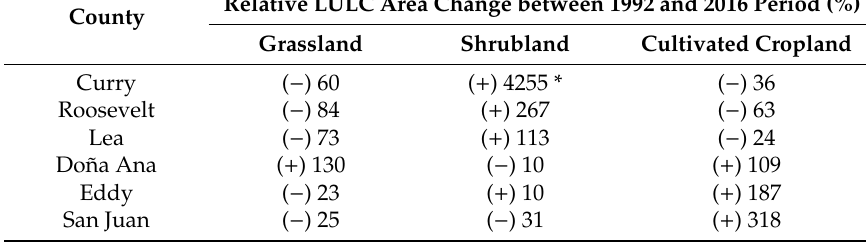
Table 8. Summary of LULC relative area change over the three classes (i.e. grassland, shrubland, and cultivated cropland) over each study counties during 1992–2016. Relative LULC Area Change between 1992 and 2016 Period (%) County Grassland